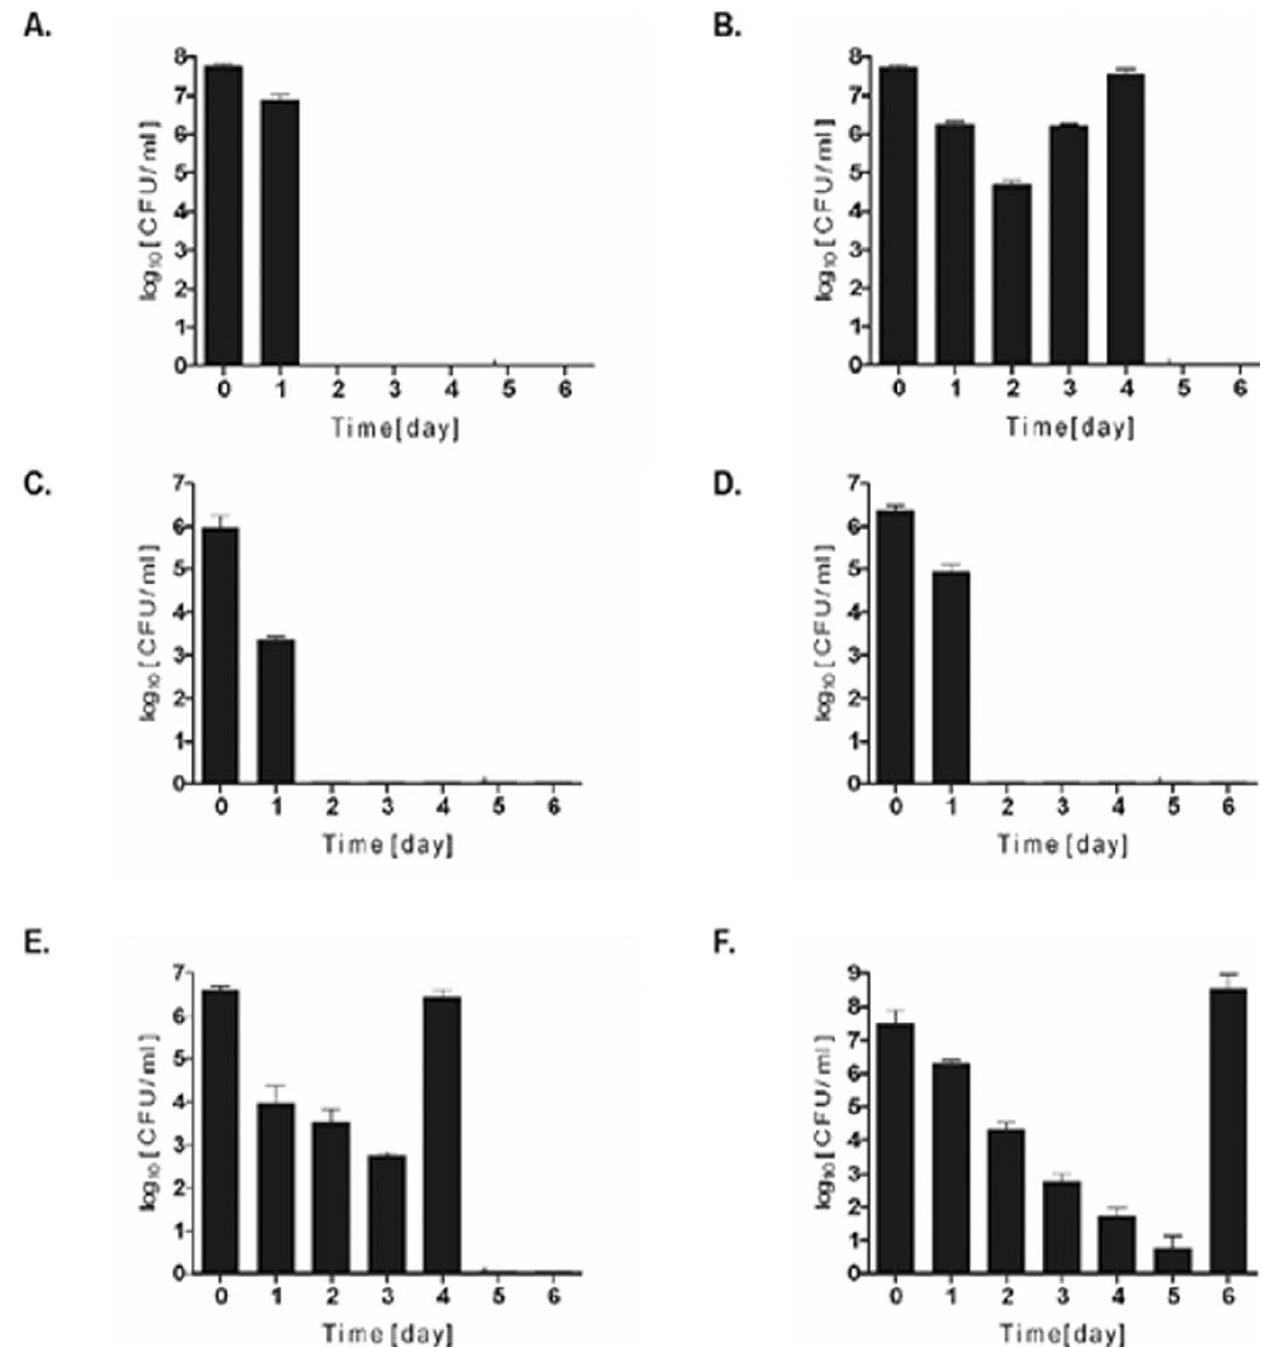
Figure 6. Functional sigBand agroperons, but not sarA, are indispensable for S.aureusto survive phagocytosis by hMDMs. Macrophages were allowed to engulf defined strains of S. aureus for 2h at a MOI of 25, and the intracellular survival of bacteria on consecutive days post-phagocytosis was monitored by enumeration of the CFU of cell lysates (see Fig. 3A legend). The data shown is representative of at least three separate experiments, performed in triplicate, using hMDMs derived from different donors. Bars represent mean CFU value 6 SD. A. 8325-4, a natural rsbU defective strain lacking a functional SigB. B. SH1000, a derivative of strain 8325-4 with a restored rsbU gene and SigB activity. C. Newman sigB mutant D. Newman agr mutant E. Newman sarA mutant F. Newman wild-type